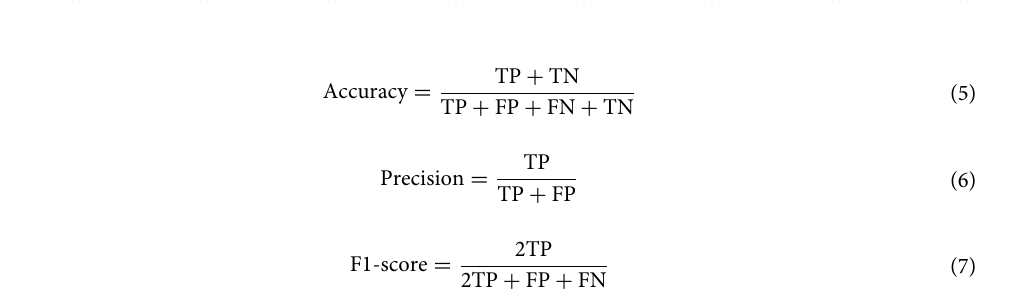
Table 1. Model evaluation based on binary confusion matrix.